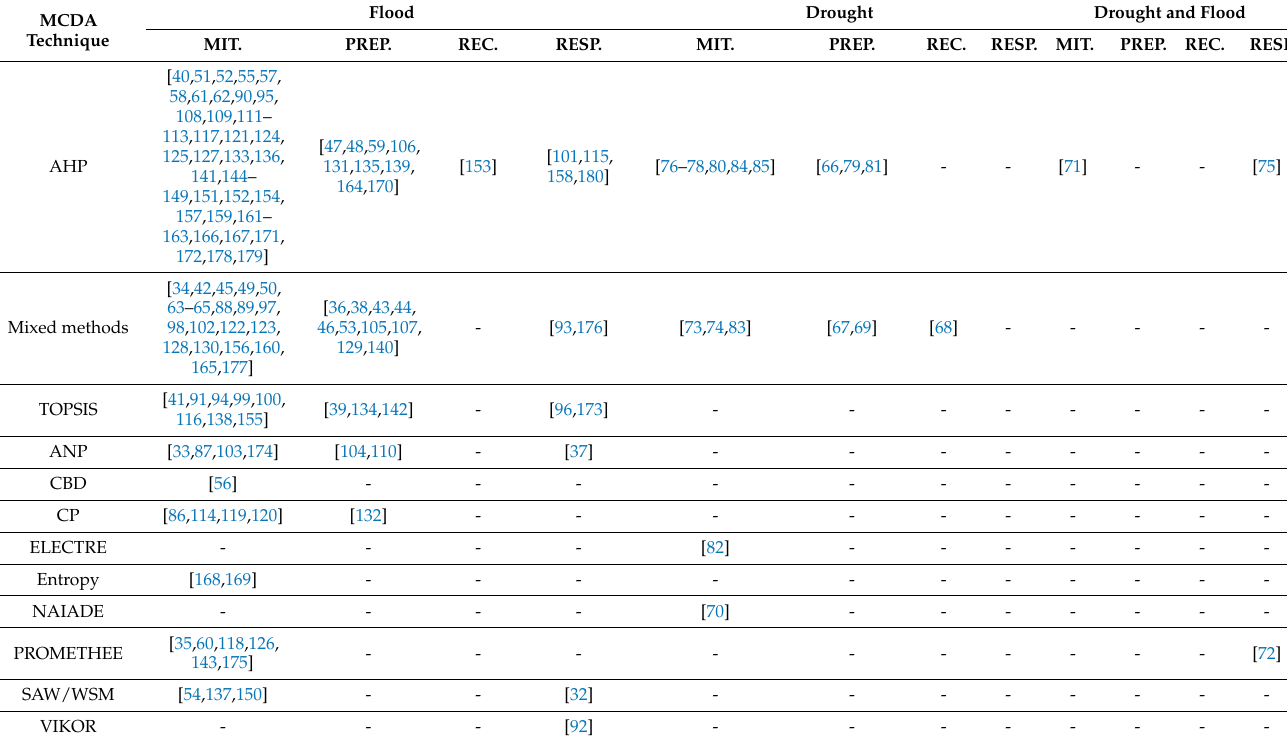
Table 9. Overall classification of MCDA techniques based on WRD events and DMP.